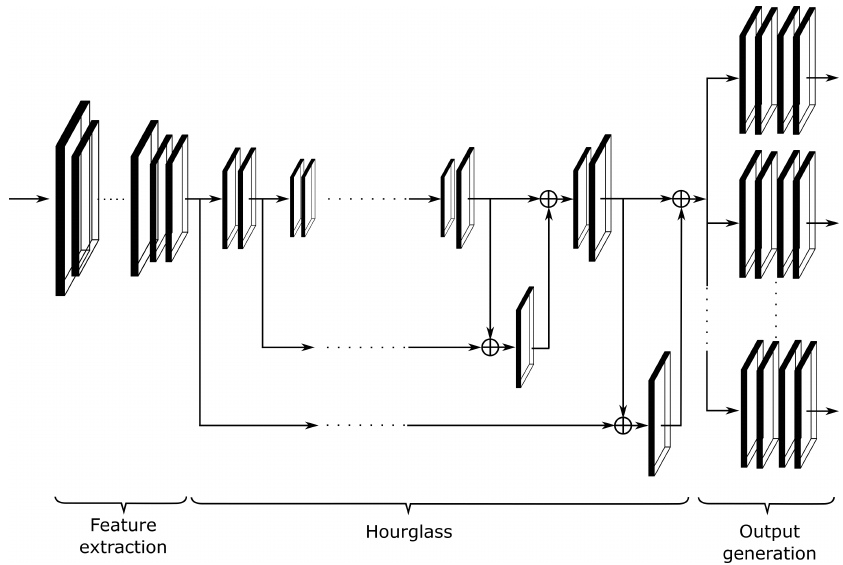
Figure 2. General structure of the neural network used for vehicle